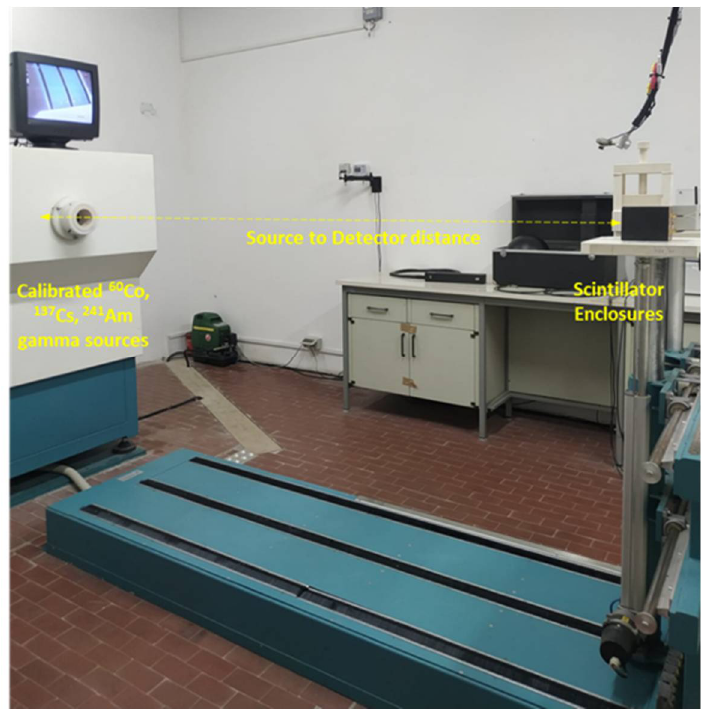
Figure 11. Setup of the measurements performed to investigate the energy dependence of the intrinsic photopeak efficiency of the detectors. Table 3. Characteristics of the exposures performed to investigate the energy dependence of the intrinsic photopeak efficiency of the detectors .